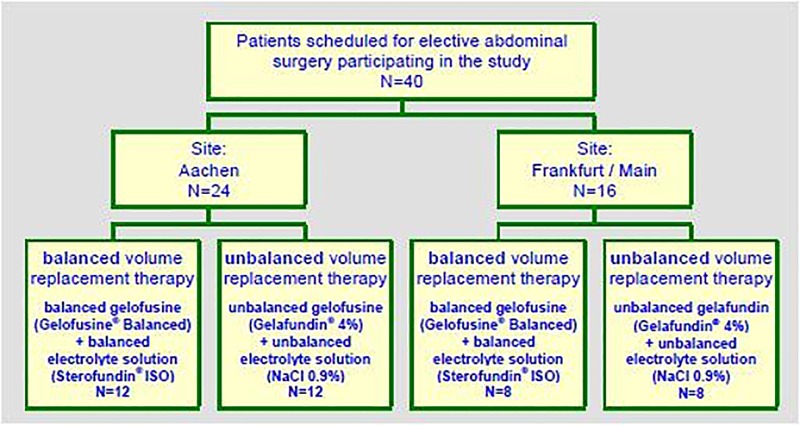
Study flow chart.